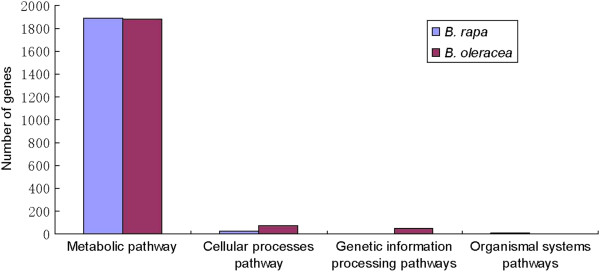
The summary enriched pathways of DEGs in B. rapa and B. oleracea.